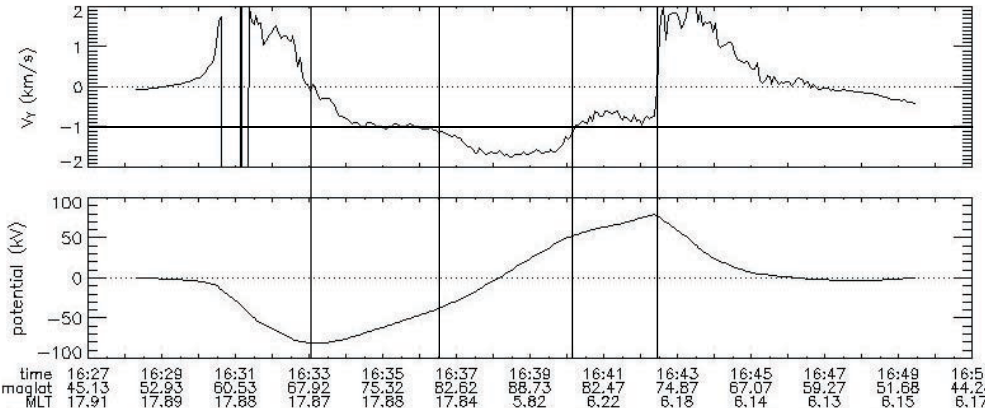
Fig. 9. DMSP F13 cross-track ion drift ( V y ) and potential curves during the interval 16:27–16:51UT. Polar cap dawn- and dusk-side boundaries and sector of enhanced antisunward flow in the central polar cap (16:37–16:40UT) are marked by vertical guidelines. Same format as in Fig. 4. The satellite track is indicated in Fig.